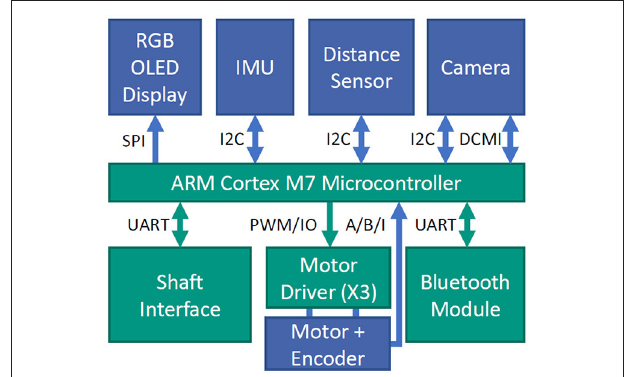
FIGURE 4 | Block diagram showing the functional units of the embedded system. Parts in green are directly placed on the central PCB, the parts in blue are separate components distributed throughout the